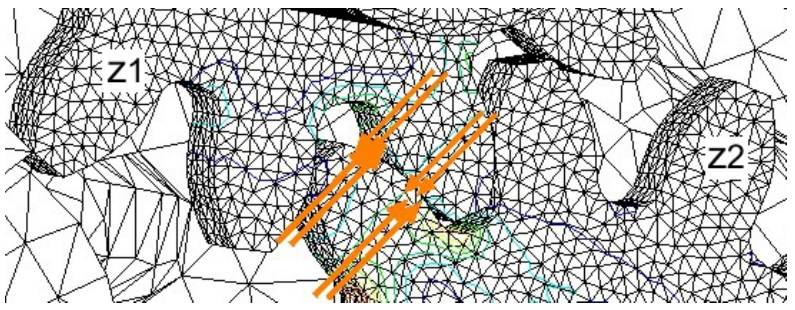
Figure 9. Forces distribution on the teeth flanks.